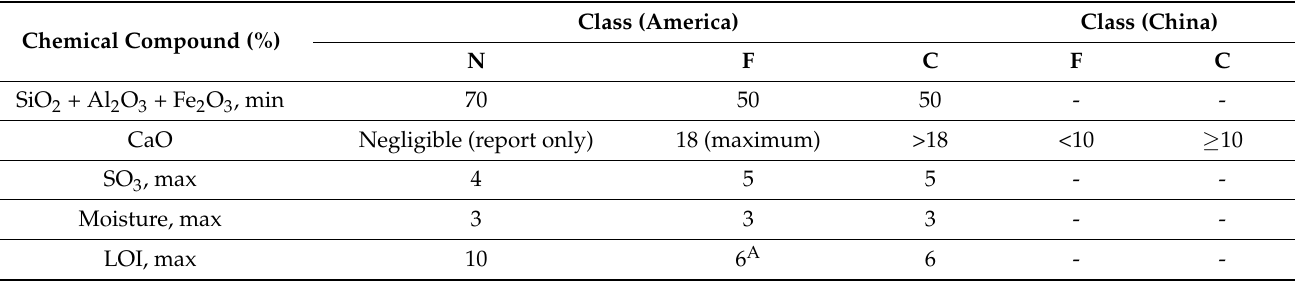
Table 1. Classification of CFA based on chemical